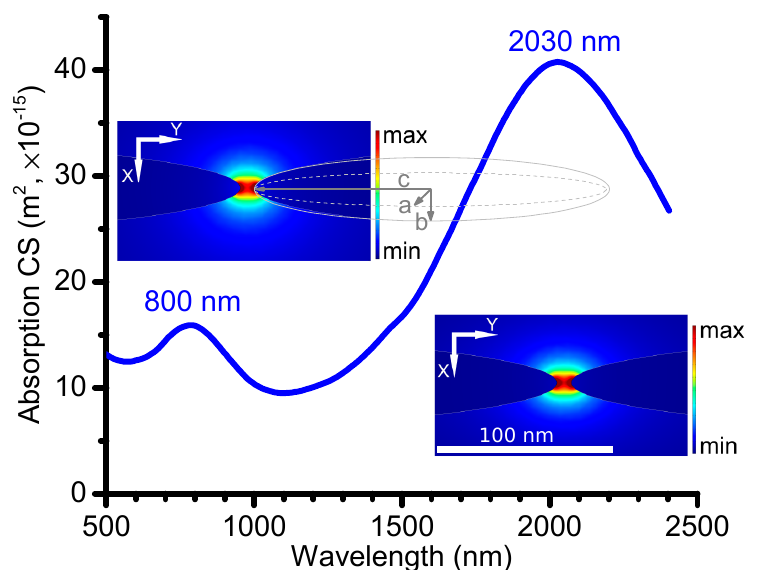
Figure 7. Simulated absorption CS of coupled identical MXene ellipsoids with semiaxes c = 100 nm, a = 40 nm and b = 10 nm. Insets: electric field intensity maps at IBT maxima—800 nm and LSP resonance at 2030